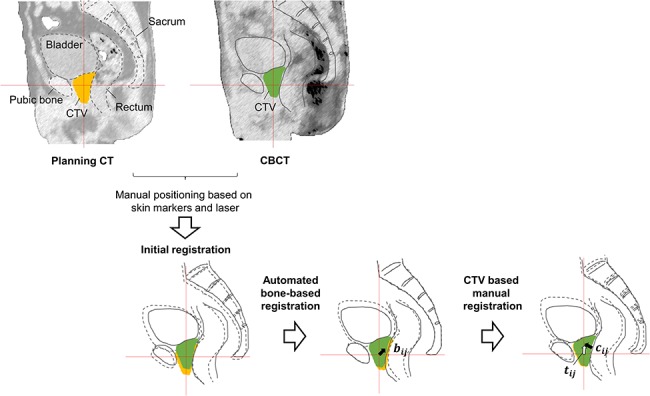
Workflow of patient positioning with image guidance based on CT and pretreatment CBCT for prostate intensity-modulated radiotherapy in sagittal view. The shift after the automated bone-based registration was \documentclass[12pt]{minimal}
\usepackage{amsmath}
\usepackage{wasysym}
\usepackage{amsfonts}
\usepackage{amssymb}
\usepackage{amsbsy}
\usepackage{upgreek}
\usepackage{mathrsfs}
\setlength{\oddsidemargin}{-69pt}
\begin{document}
}{}${\boldsymbol{b}}_{ij}$\end{document}, and that after the CTV based manual registration was \documentclass[12pt]{minimal}
\usepackage{amsmath}
\usepackage{wasysym}
\usepackage{amsfonts}
\usepackage{amssymb}
\usepackage{amsbsy}
\usepackage{upgreek}
\usepackage{mathrsfs}
\setlength{\oddsidemargin}{-69pt}
\begin{document}
}{}${\boldsymbol{c}}_{ij}$\end{document}. The \documentclass[12pt]{minimal}
\usepackage{amsmath}
\usepackage{wasysym}
\usepackage{amsfonts}
\usepackage{amssymb}
\usepackage{amsbsy}
\usepackage{upgreek}
\usepackage{mathrsfs}
\setlength{\oddsidemargin}{-69pt}
\begin{document}
}{}${\boldsymbol{c}}_{ij}$\end{document} was employed as the reference CTV shift. Total patient shift is indicated as \documentclass[12pt]{minimal}
\usepackage{amsmath}
\usepackage{wasysym}
\usepackage{amsfonts}
\usepackage{amssymb}
\usepackage{amsbsy}
\usepackage{upgreek}
\usepackage{mathrsfs}
\setlength{\oddsidemargin}{-69pt}
\begin{document}
}{}${\boldsymbol{t}}_{ij}.$\end{document}